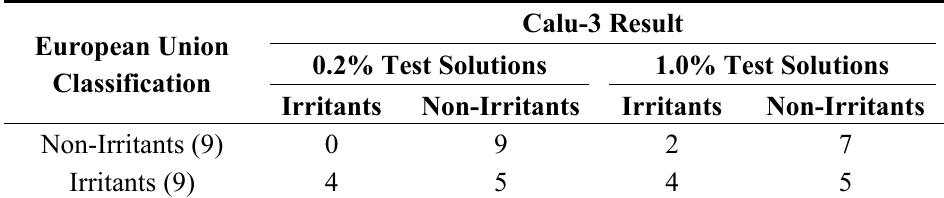
Table 4. Comparison of validation data, based on test compound concentration and 60 min exposure to Calu-3 cells.